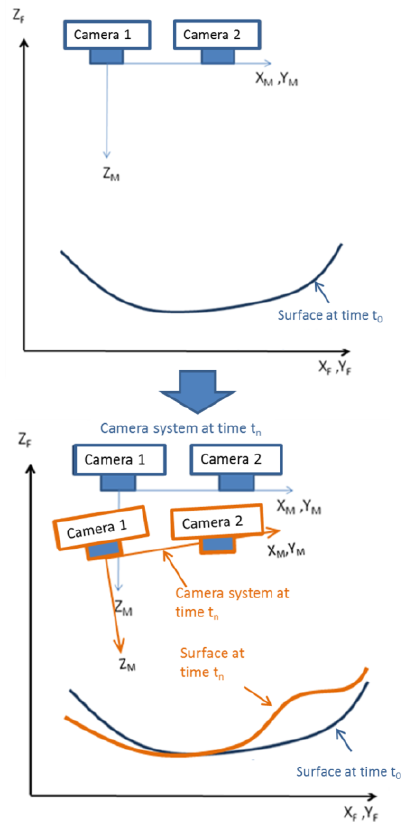
Figure 1. Possible camera- and object-movements, and object deformations between time t 0 and time t